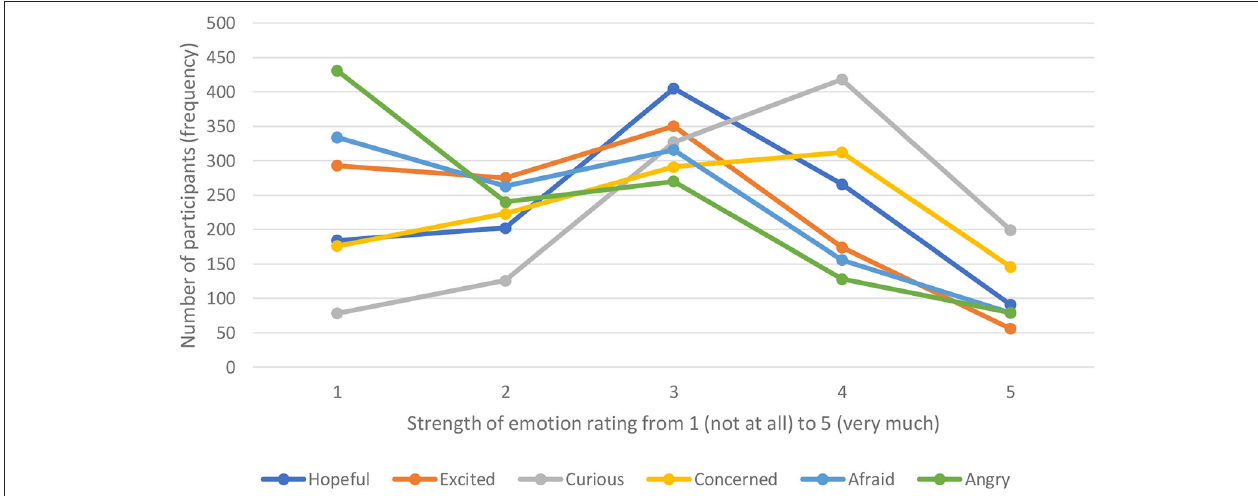
FIGURE 3 | Emotion rating frequencies for feelings toward gene marking technology in chickens, where lower scores indicate a weaker feeling, and higher scores indicate a stronger feeling.